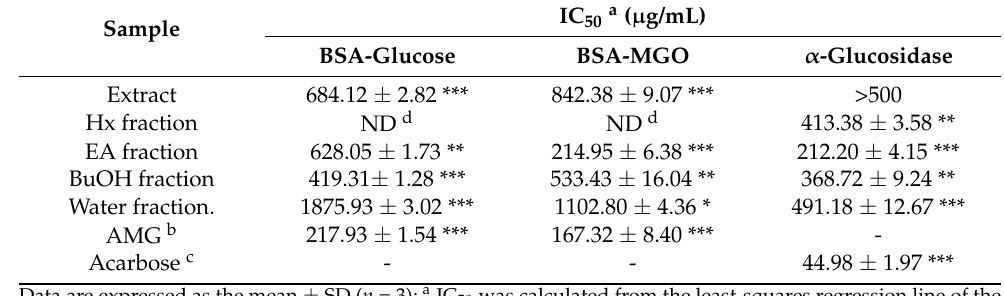
Table 1. IC 50 (inhibitory activity) of the Benicasae Exocarpium (BE) extract and fractions against advanced glycation end-products (AGEs) formation in bovine serum albumin (BSA)-glucose and BSA-methylglyoxal (MGO) systems and α -glucosidase.